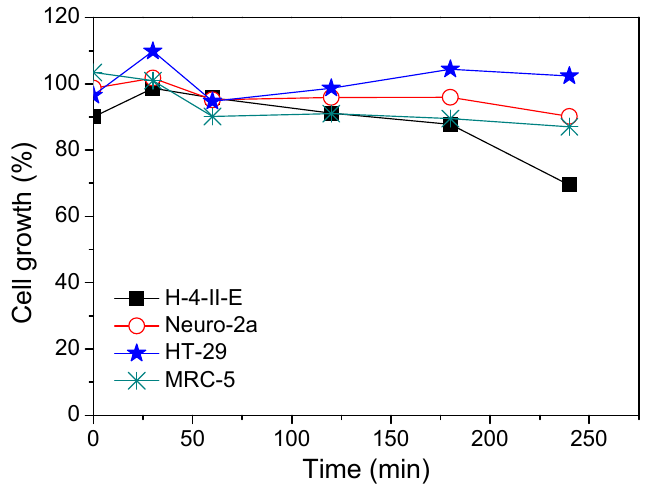
Figure 9. Cytotoxic activity of AMI (0.0300 mmol/L) and intermediates formed during photocatalytic degradation using ZnO (1.0 mg/mL) and solar radiation on the selected cell lines.